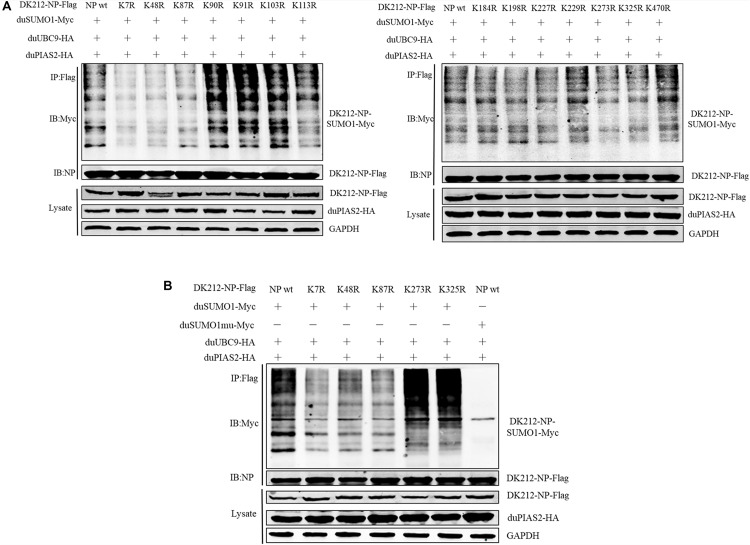
K7, K48, and K87 of DK212 NP were potential SUMOylation site. (A) HEK 293T cells were transfected with SUMOylation-related expression plasmids and individual specific K-to-R mutant constructs of NP and NPwt. (B) HEK 293T cells were transfected with SUMOylation-related expression plasmids and NP, K7R, K48R, K87R, K273R, or K325R mutant NP to further confirm the SUMOylation sites of NP. After 36 h, the transfected cells were lysed and immunoprecipitated with anti-Flag agarose beads. The cellular lysates and immunoprecipitation complexes were analyzed by immunoblotting with the indicated antibodies.